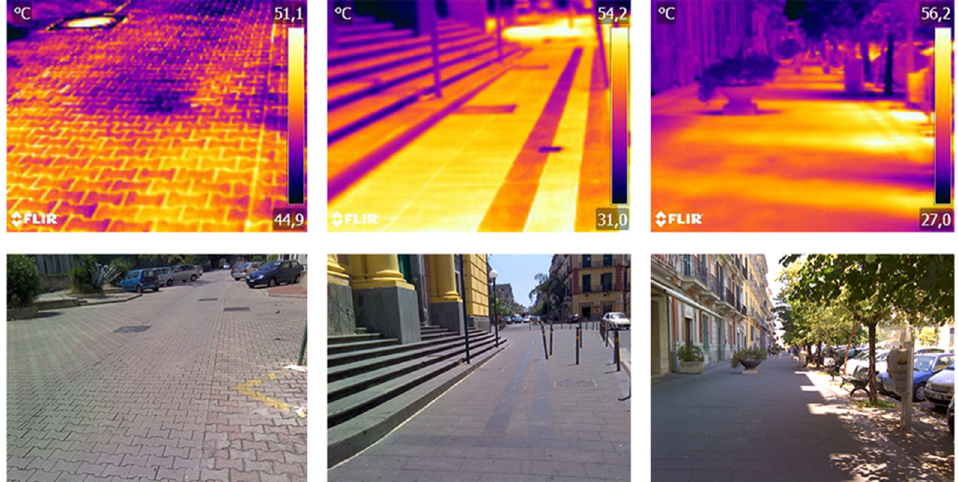
Figure A5. Thermographic surveys of the 3 July 2015 of “Lotto PSER” in Fratelli Grimm Avenue (P19), Vincenzo Aprea Square (P29), Margherita Avenue (P31).